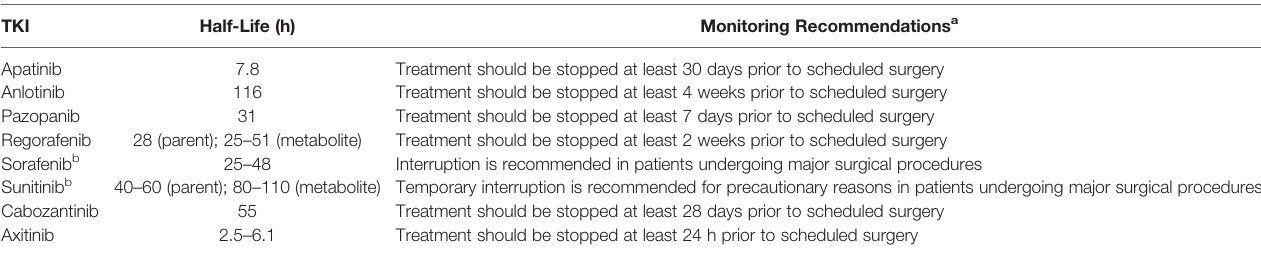
TABLE 3 | Summary of regulatory recommendations concerning the use of TKIs prior to